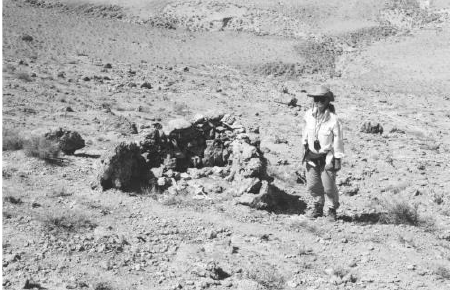
Figure 10. A hunter’s blind. Photo : M. Stout Whiting 2000.